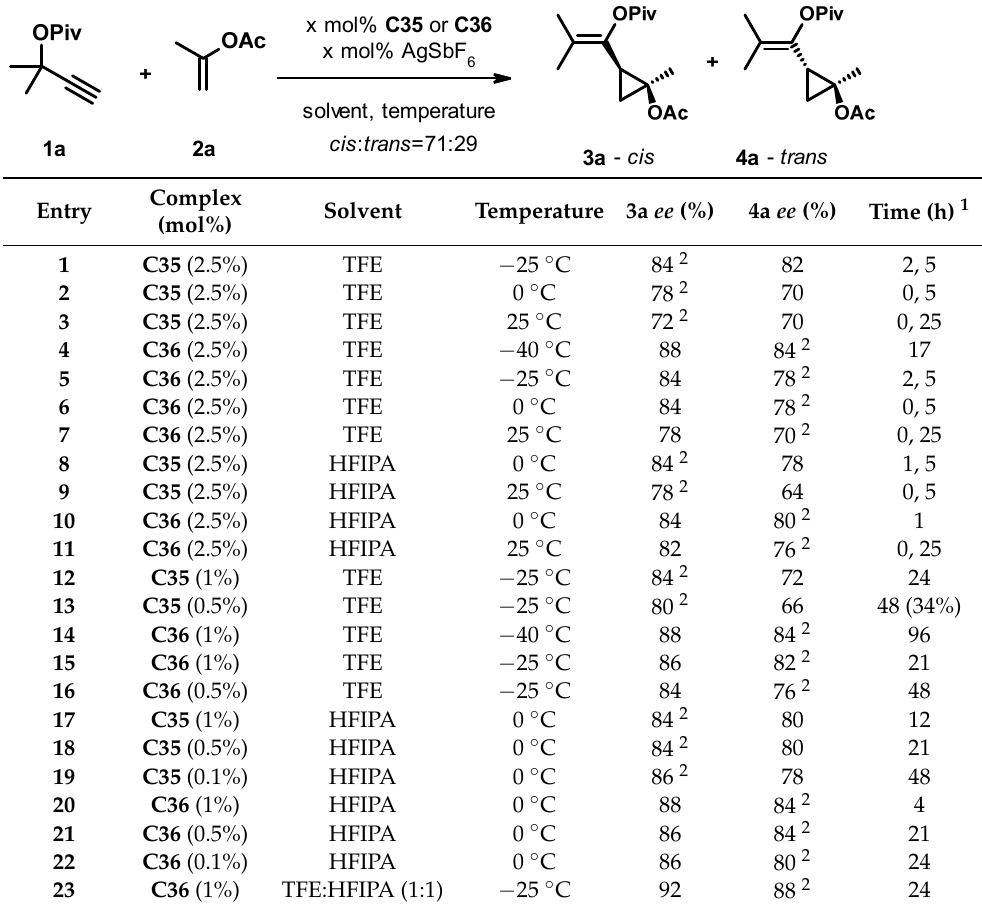
Table 4. Fine-tuning the catalyst loading and the reaction temperature in the asymmetric cyclopropanation.